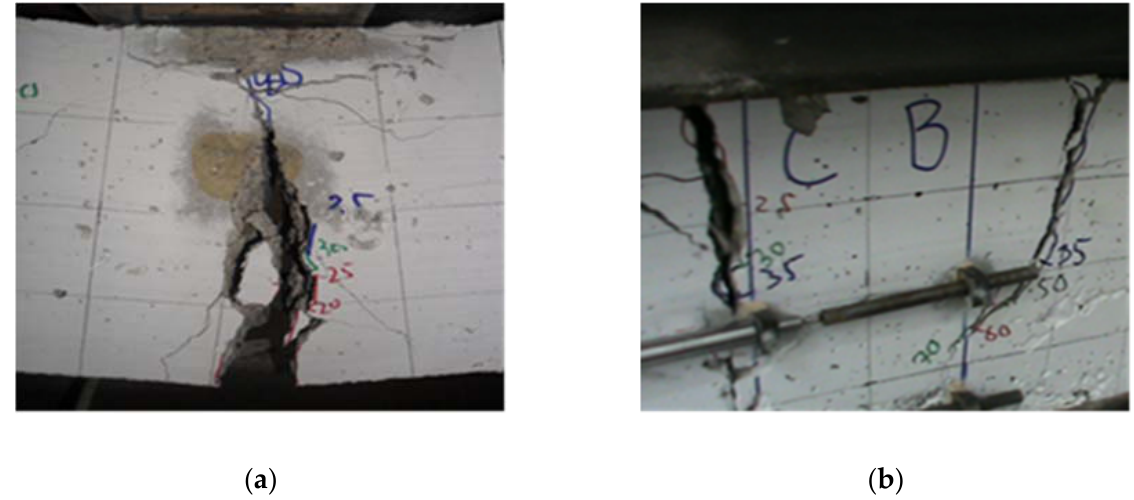
Figure 16. Control beam: ( a ) Failure of the cross-section at mid-span of control beam; ( b ) Failure of the cross-section above